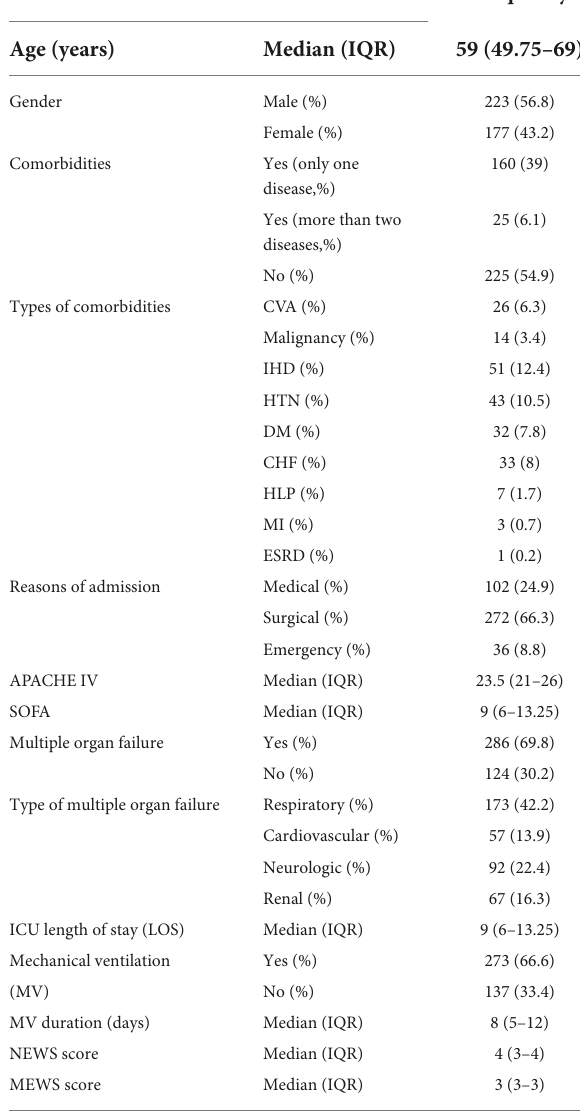
TABLE 1 Demographic and clinical characteristics data of all patients ( n =